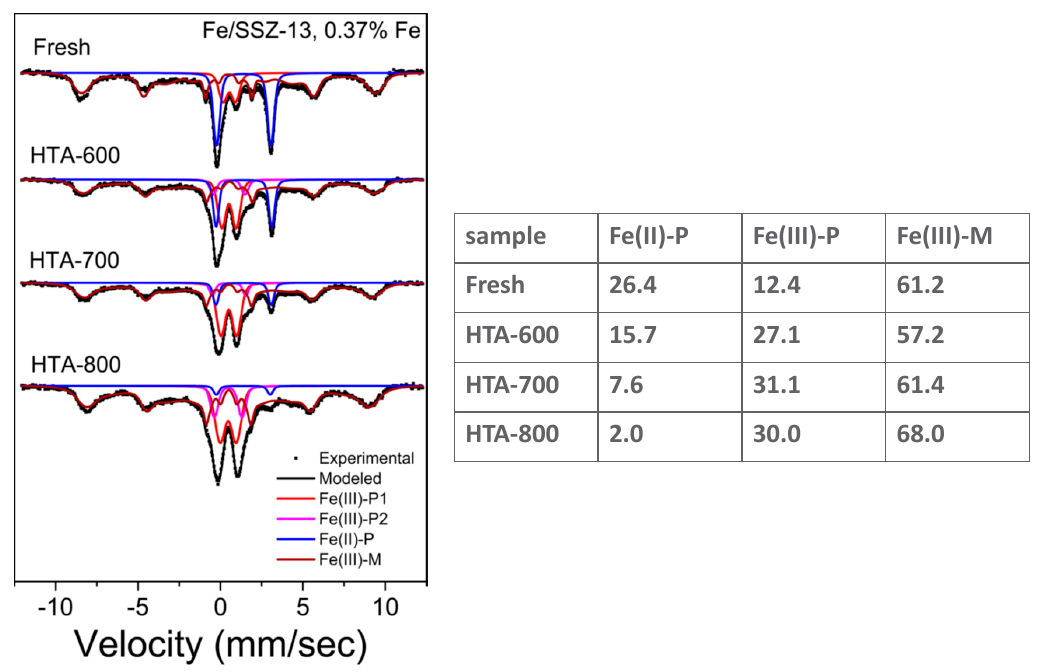
Figure 13. Experimental and simulated Mössbauer results for fresh and HTA Fe / SSZ-13 samples (0.37% Fe loading) measured at 7 K. Reprinted with permission from [32]. Copyright © 2017 American Chemical Society.